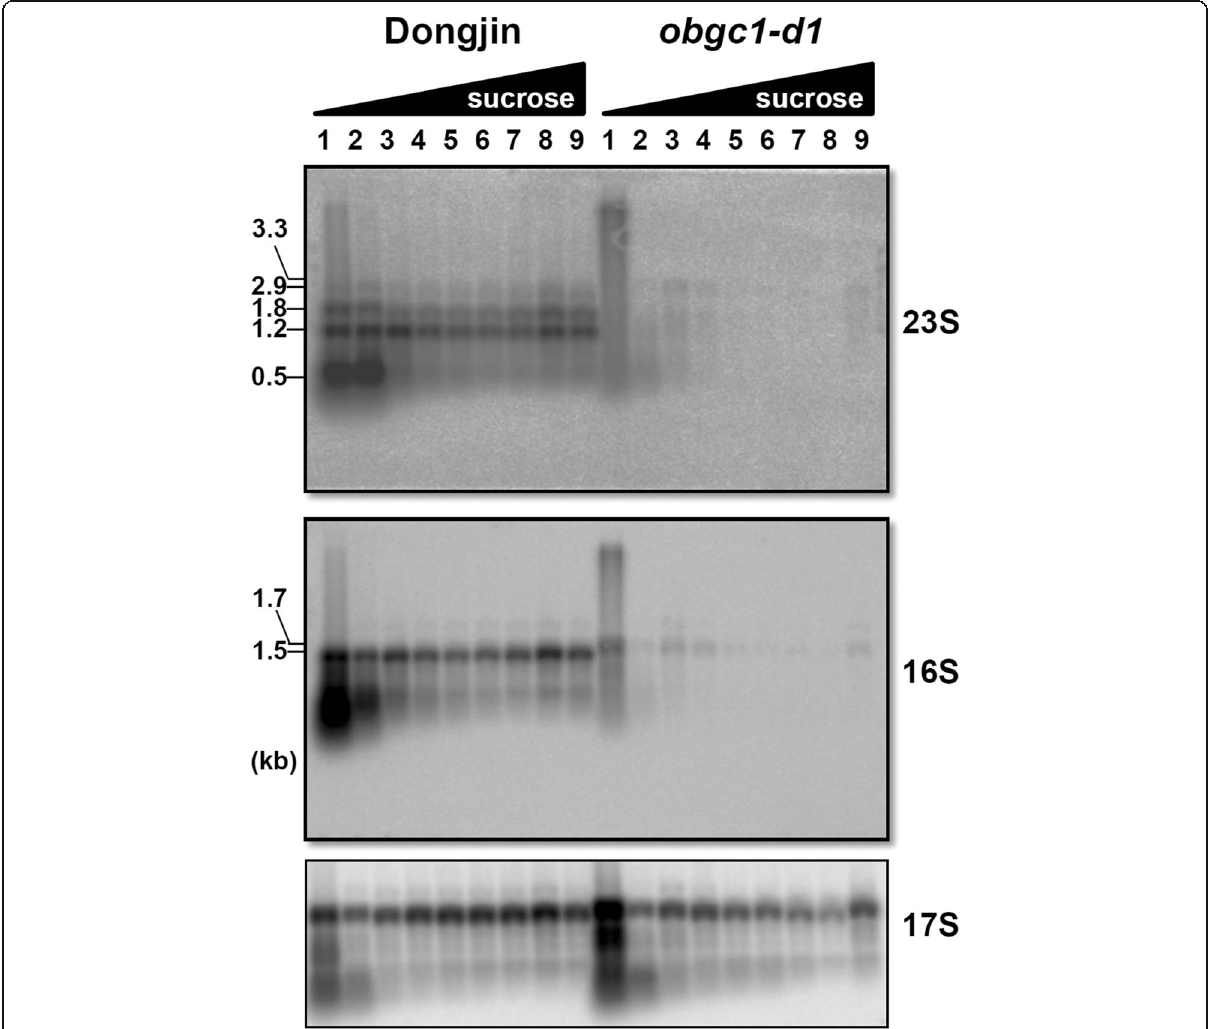
Fig. 11 Analysis of polysome fractions in wild-type and obgc1-d1 mutant plants. Total ribosomes from leaves of 10-day-old wild-type (Dongjin) and obgc1-d1 mutant plants were separated by a sedimentation ultracentrifugation in a 15 – 55% sucrose gradient. Nine fractions (1 – 9) of equal volume were collected from top to bottom. RNAs from each fraction were separated on 1.2% agarose gels, transferred to nylon membranes, and hybridized with probes prepared from gene-specific sequences for 16S/23S rRNAs. Cytosolic 17S rRNA (17S) was used as a loading or negative